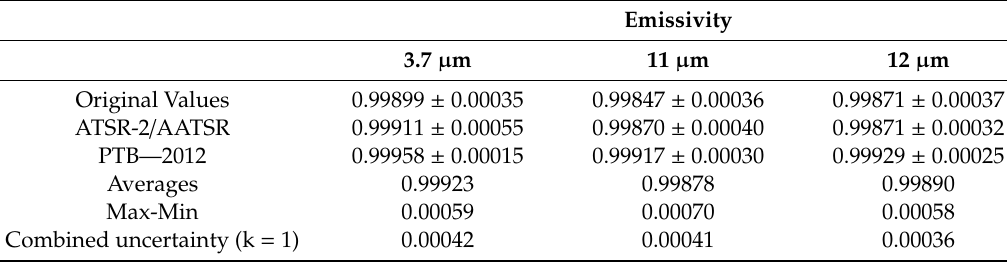
Table 3. Emissivities of the reference BB sources used in the pre-launch calibration tests of SLSTR. The original values from [16] are based on witness measurements of the Nextel coating and a geometric model of the BB source. The second row is by analysis of the ATSR-2 and AATSR radiometric calibration results against the flight BB sources [15], and the third row is an analysis performed